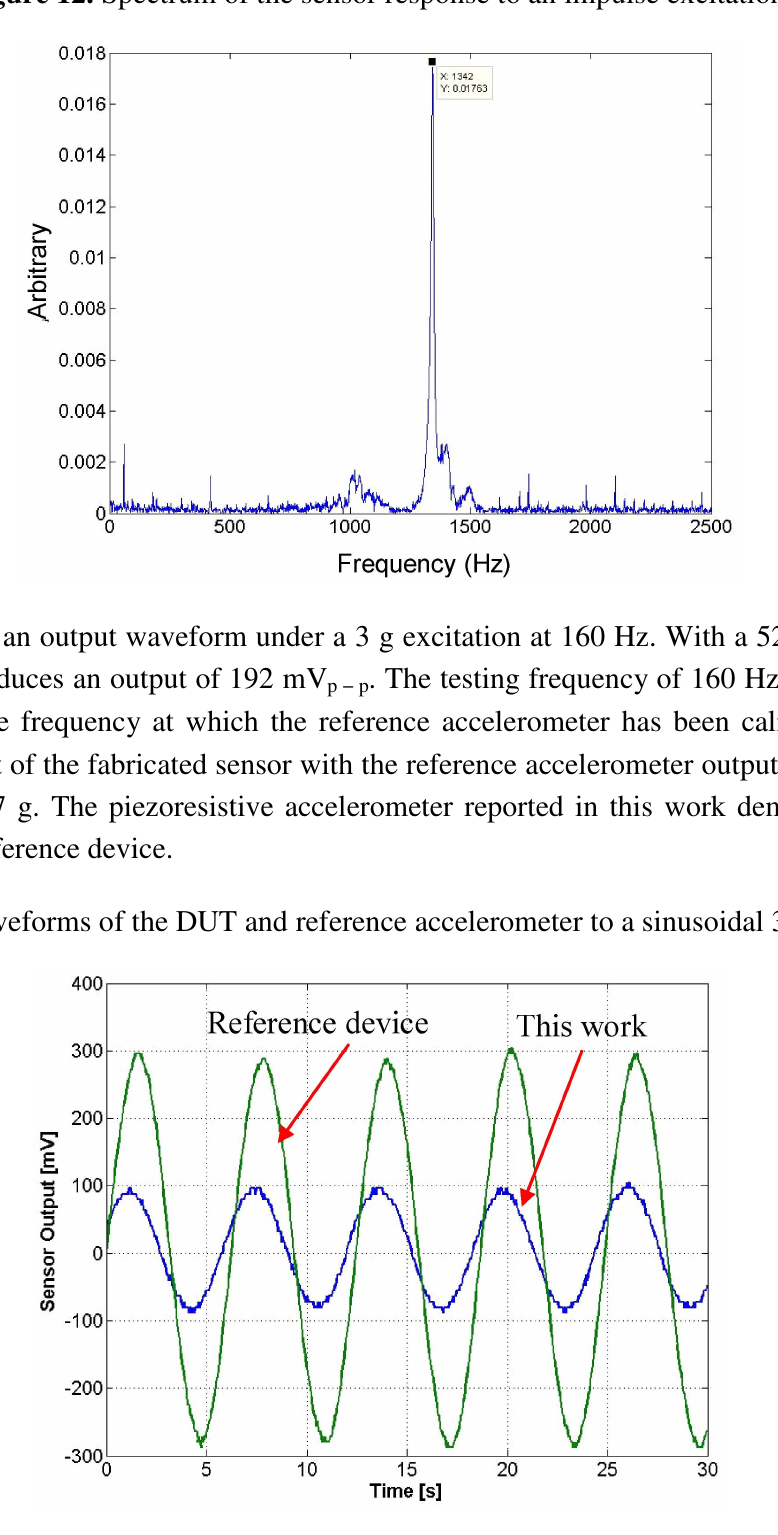
Figure 12. Spectrum of the sensor response to an impulse excitation.